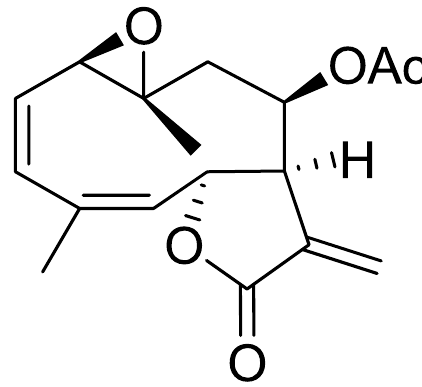
Figure 1. Structure of incomptine A ( IA